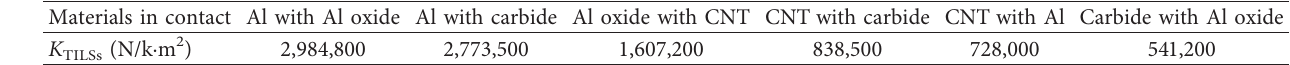
Table 7: The values of K TILSs for two materials in contact.